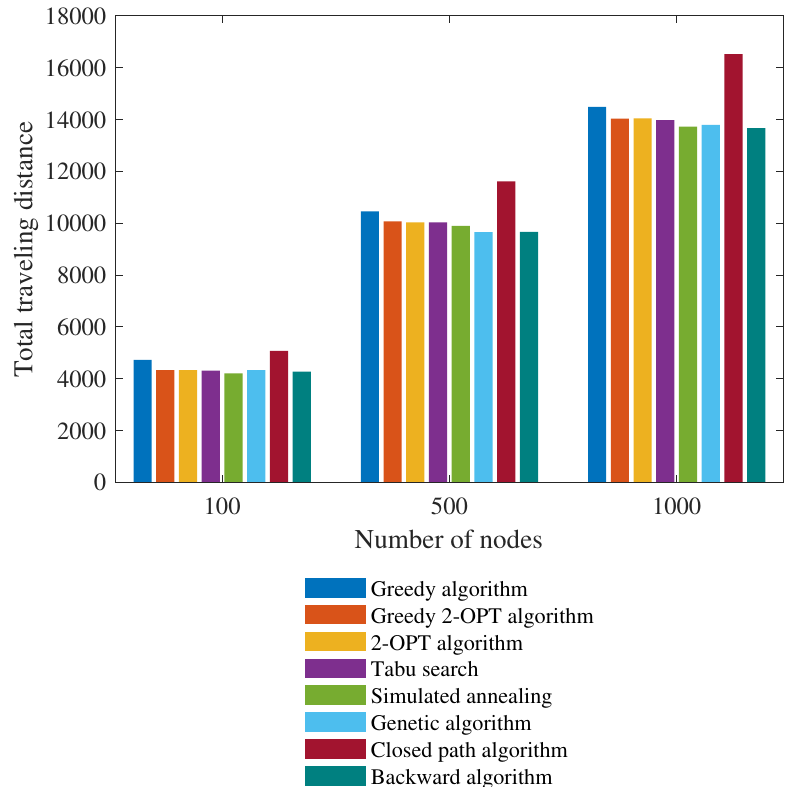
Figure 6. Comparison of the traveling salesman problem (TSP) solutions using various heuristic